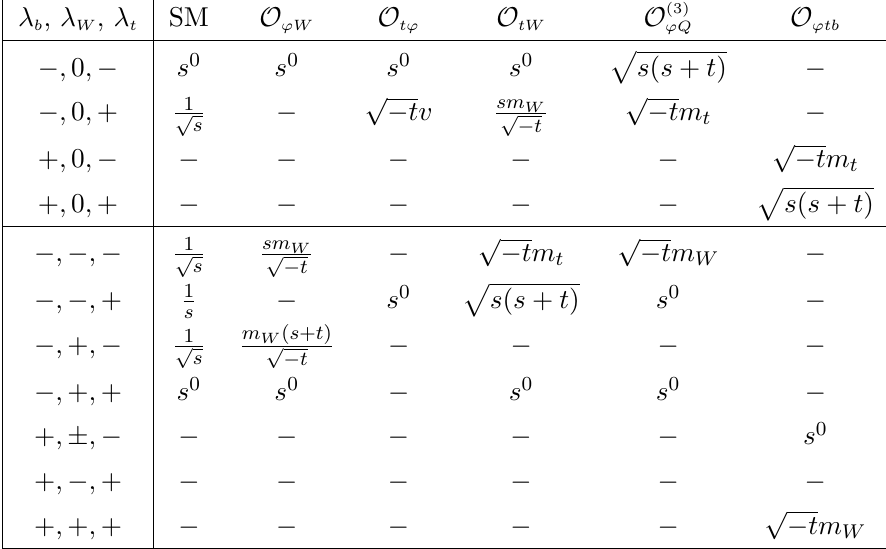
t v ) for b W + t h scattering. (cid:24) (cid:0) (cid:29) ! ’ indicate any combination of ; . See (cid:3) (cid:6) (cid:7)